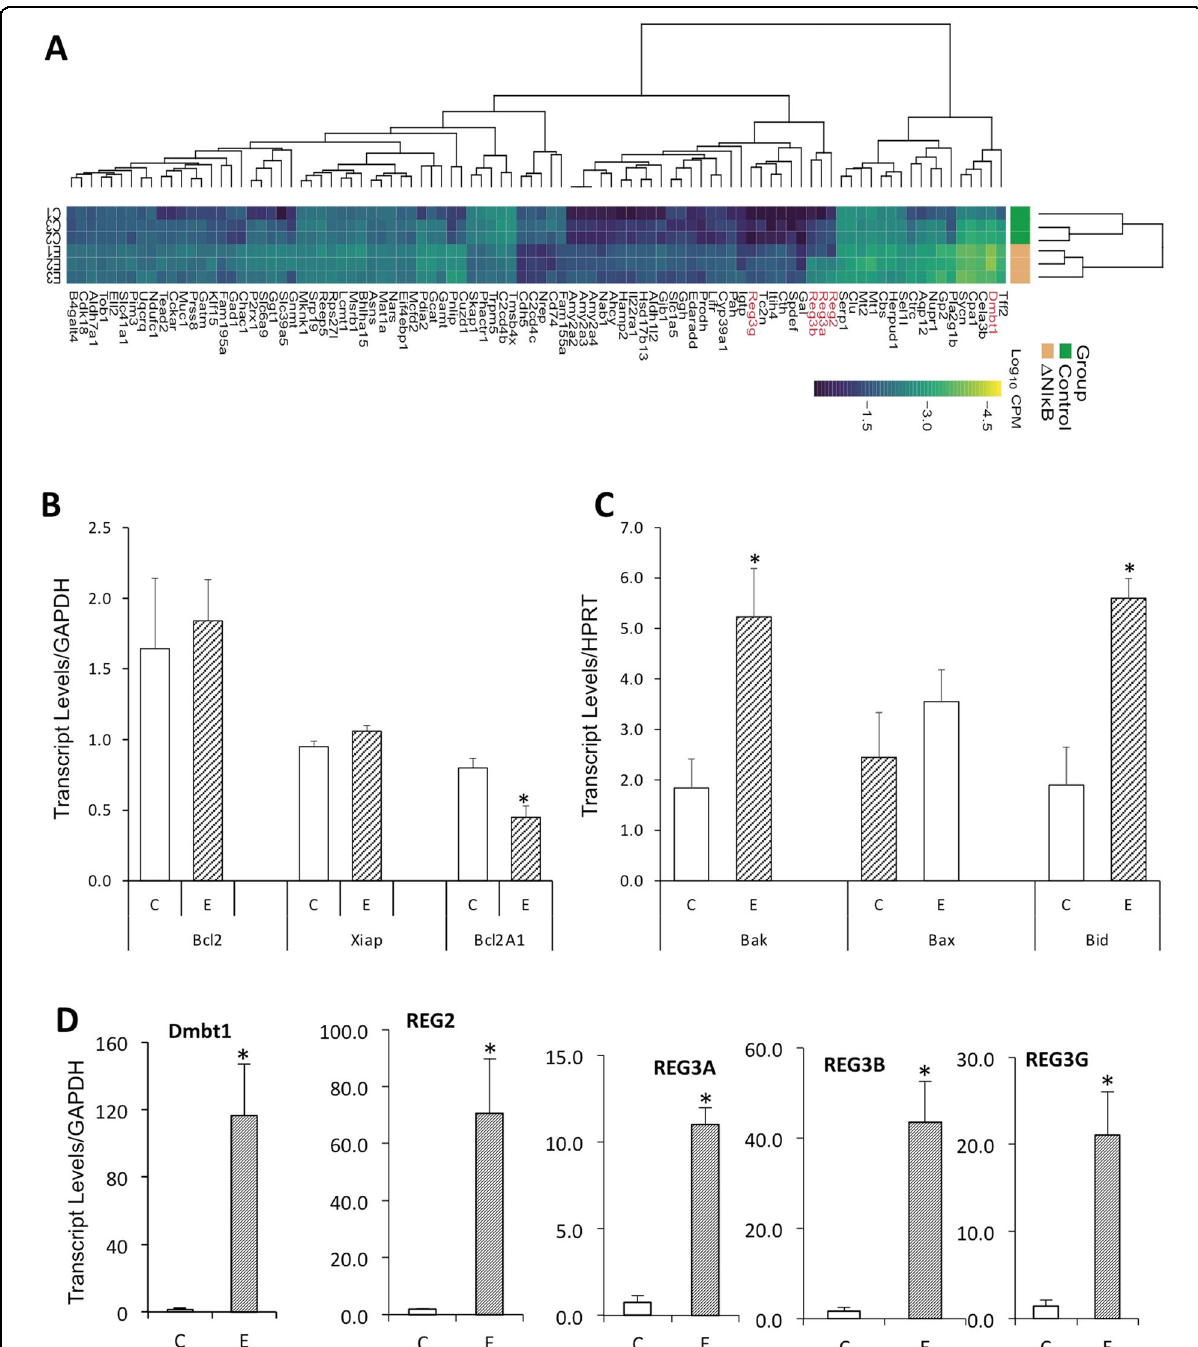
Fig. 7 Embryonic inhibition of the NF- κ B pathway in insulin-expressing cells differentially regulates the expression of genes in islets of young mice as evaluated by RNA-Seq. A Heatmap showing differentially expressed genes in islets isolated from 3-week-old mice where Δ NI κ B α was transiently expressed during the embryonic period (E1, E2, E3) as compared to controls (C1, C2, C3). mRNAs were hierarchically clustered using Ward ’ s method and Manhattan distance metric. In the heatmap, darker shades represent a higher expression. Reg family genes and Dmbt1 are depicted in red. B (anti-apoptotic genes), C (pro-apoptotic genes), D (genes associated with regeneration). Validation by RT-qPCR panel of mRNA levels of selected genes in control islets (C-Empty bars) and in islet isolated from NOD/ToI β in which NF- κ B pathway was inhibited during the embryonic period (E-hatched bars). GAPDH or HPRT served as an internal standard. The data are presented as the mean ± SEM of n = 3 – 4 experiments. * P values <